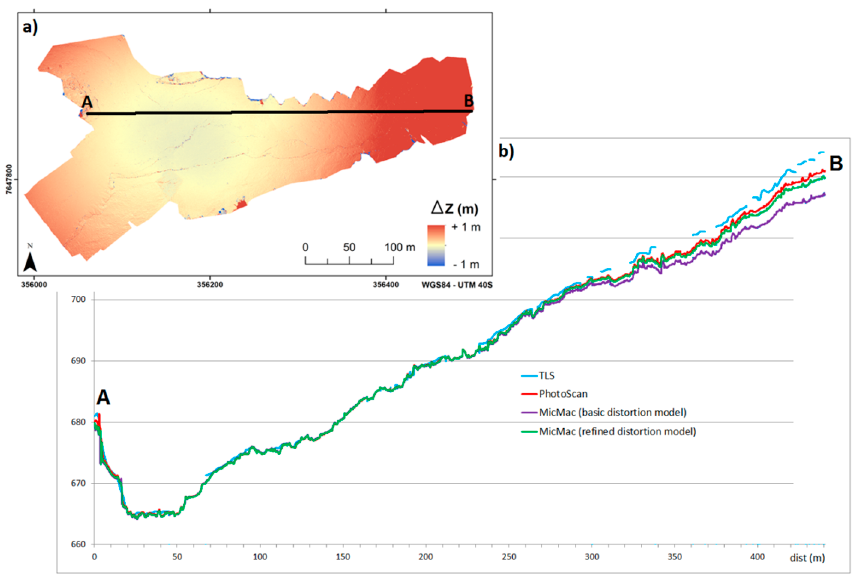
Figure 7. ( a ) Digital Elevation Model (DEM) of Difference for scenario 1 between the MicMac Digital Surface Model (DSM) with the refined distortion model (MicMac-rdm) and MicMac DSM with the basic distortion model; ( b ) Comparison of altitude along the same profile extracted from the TLS point cloud, PhotoScan DSM, MicMac DSM (with basic distortion model) and MicMac-rdm DSM (with refined distortion model).